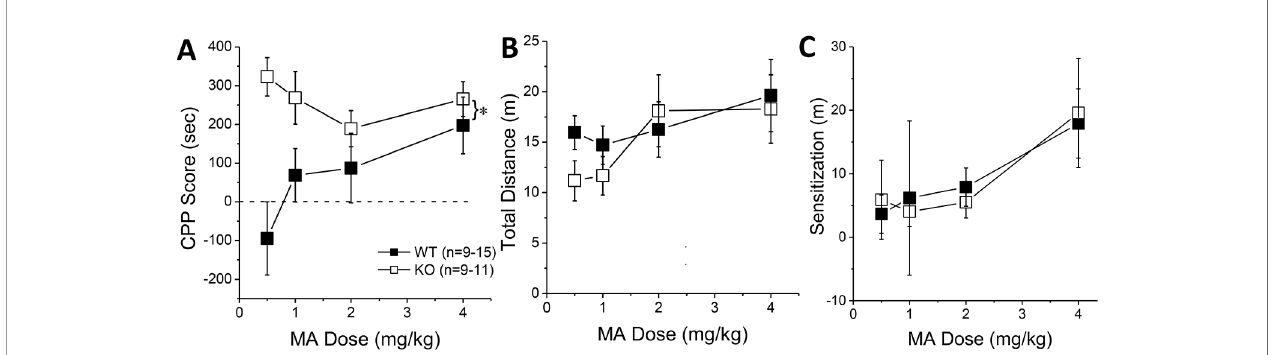
FIGURE 3 | Constitutive Homer2 deletion augments a methamphetamine (MA)-induced conditioned place-preference (CPP). When compared to wild-type (WT) mice, Homer2 knockout (KO) animals exhibited (A) a shift upwards in the dose-response function for a MA-induced CPP. In contrast, gene deletion did not alter the dose-response functions for (B) acute MA-induced locomotor activity or (C) the increase in locomotor activity from the fi rst to the last MA-conditioning session (sensitization). The data represent the means ± SEMs of the number of mice indicated in Panel A . *p < 0.05 vs. WT (main Genotype